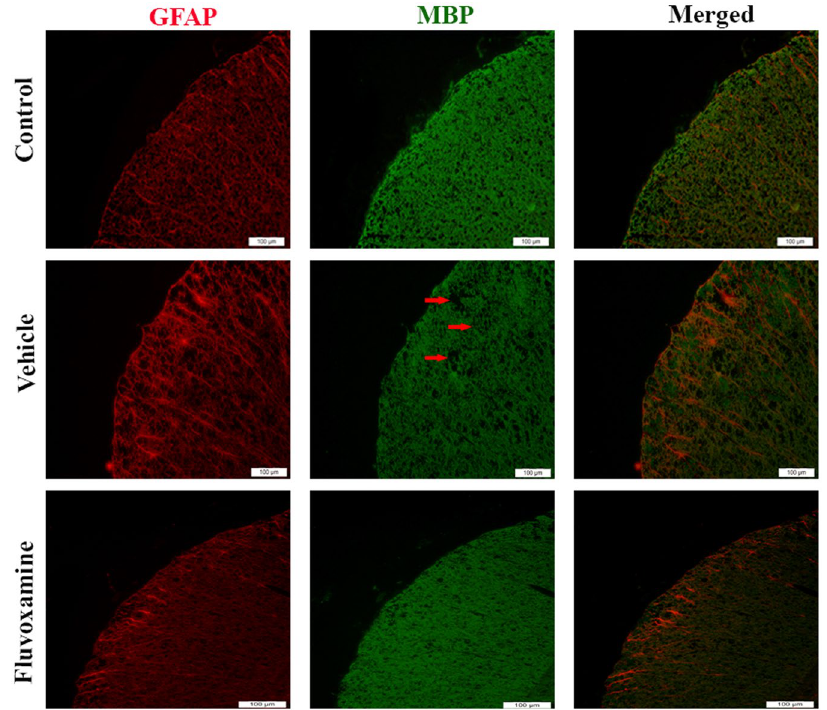
Figure 9. Immunohistochemical staining of myelin basic protein (MBP) and glial fibrillary acid protein (GFAP). Fluvoxamine caused an increase in MBP in demyelination area (red arrow) and GFAP positive cells (red). Scale bars = 100 μ